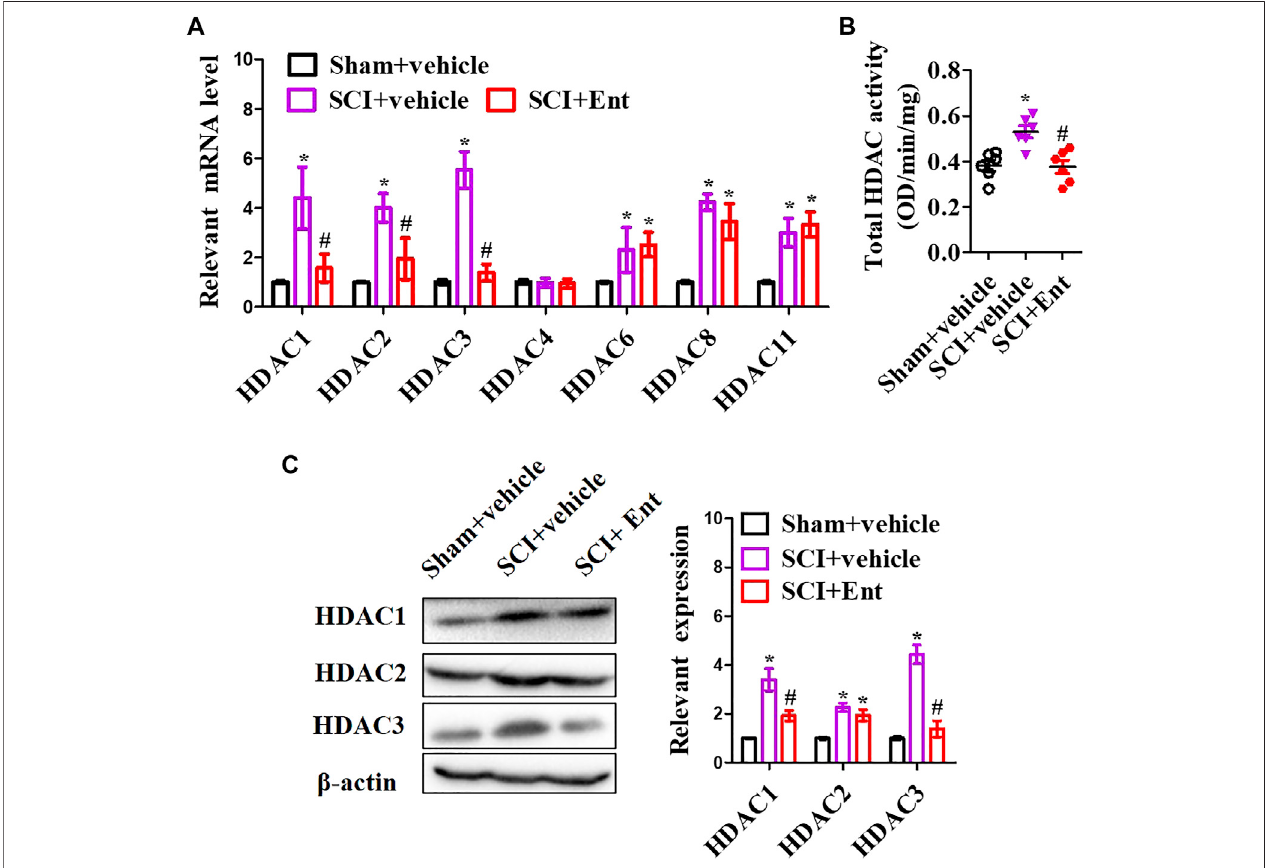
FIGURE 3 | Entinostat suppresses HDAC1 and HDAC3 expressions in the spinal cord after SCI. (A) 7 days following SCI, HDAC1, HDAC2, HDAC3, HDAC4, HDAC6, HDAC8, and HDAC11 mRNA concentrations were measured. (B) Enzymatic activity of total HDAC was evaluated using the EpiQuik HDAC Activity/Inhibition Assay Kit. (C) WB analysis of HDAC1, HDAC2, and HDAC3 expressions in the spinal cord following SCI at 7 days. Data are expressed as the mean ± SEM, n (cid:1) 5. * p < 0.05, vs. the sham + vehicle group; # p < 0.05, vs. the SCI + vehicle group.